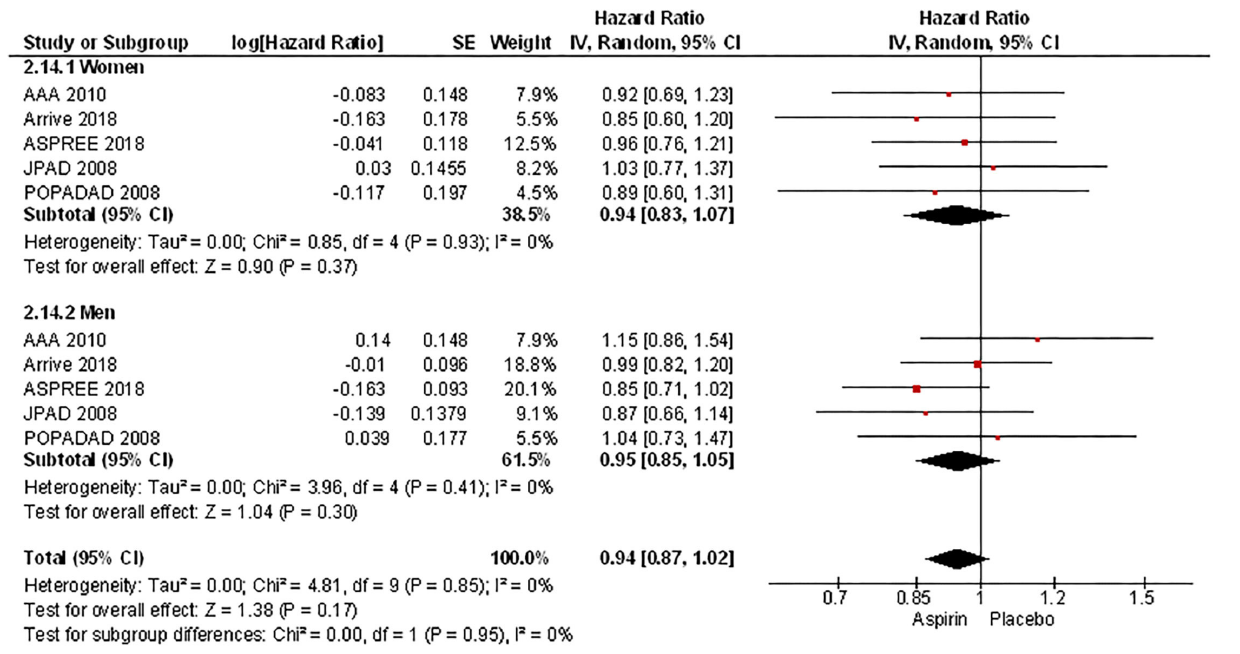
FIGURE 11 | Hazard ratio of composite outcome women and men taking